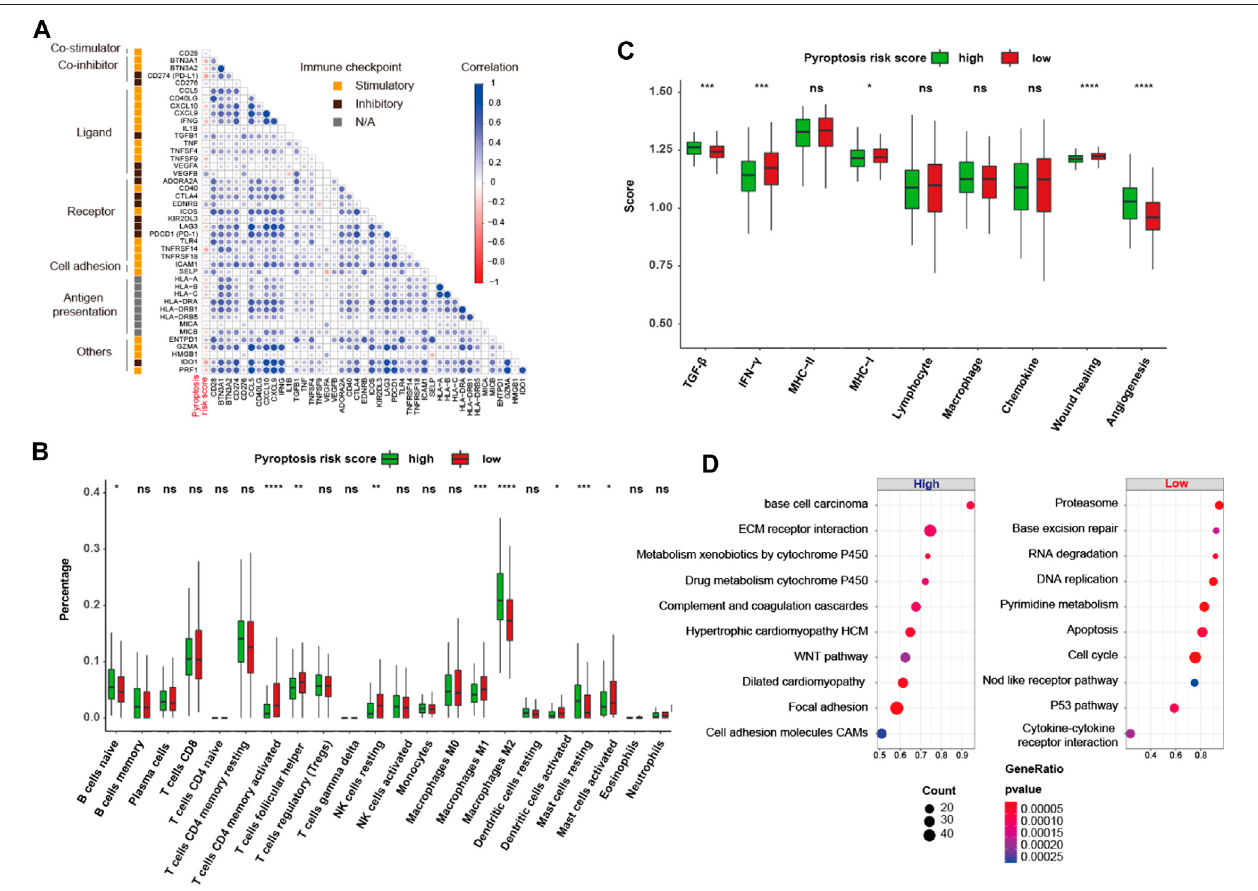
FIGURE 9 | Gene regulation and biological phenotypes of the high- and low-pyroptosis risk score groups. (A) Correlation matrix heatmap of stimulatory and inhibitory immune checkpoints. (B,C) Proportion of the 22 immune cell fractions and immune signatures between the high- and low-pyroptosis risk score groups. (D) Bubble plot of top 10 enrichment GSEA pathways. ns: not signi fi cant; * p < 0.05; ** p < 0.01; *** p < 0.001; **** p < 0.0001.